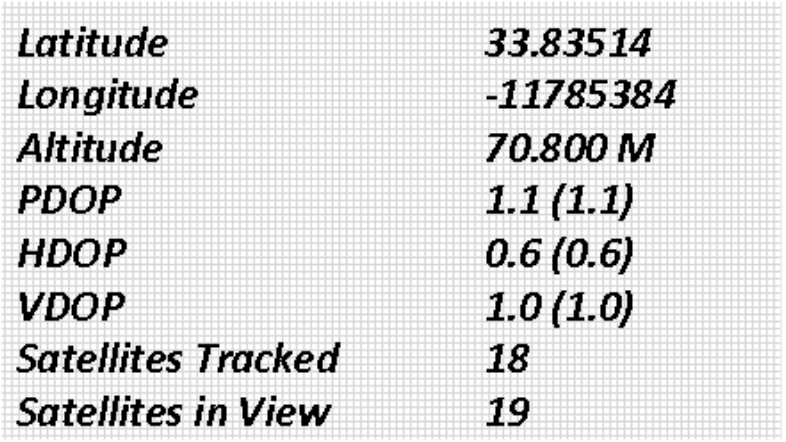
Figure 6. GPS Module output